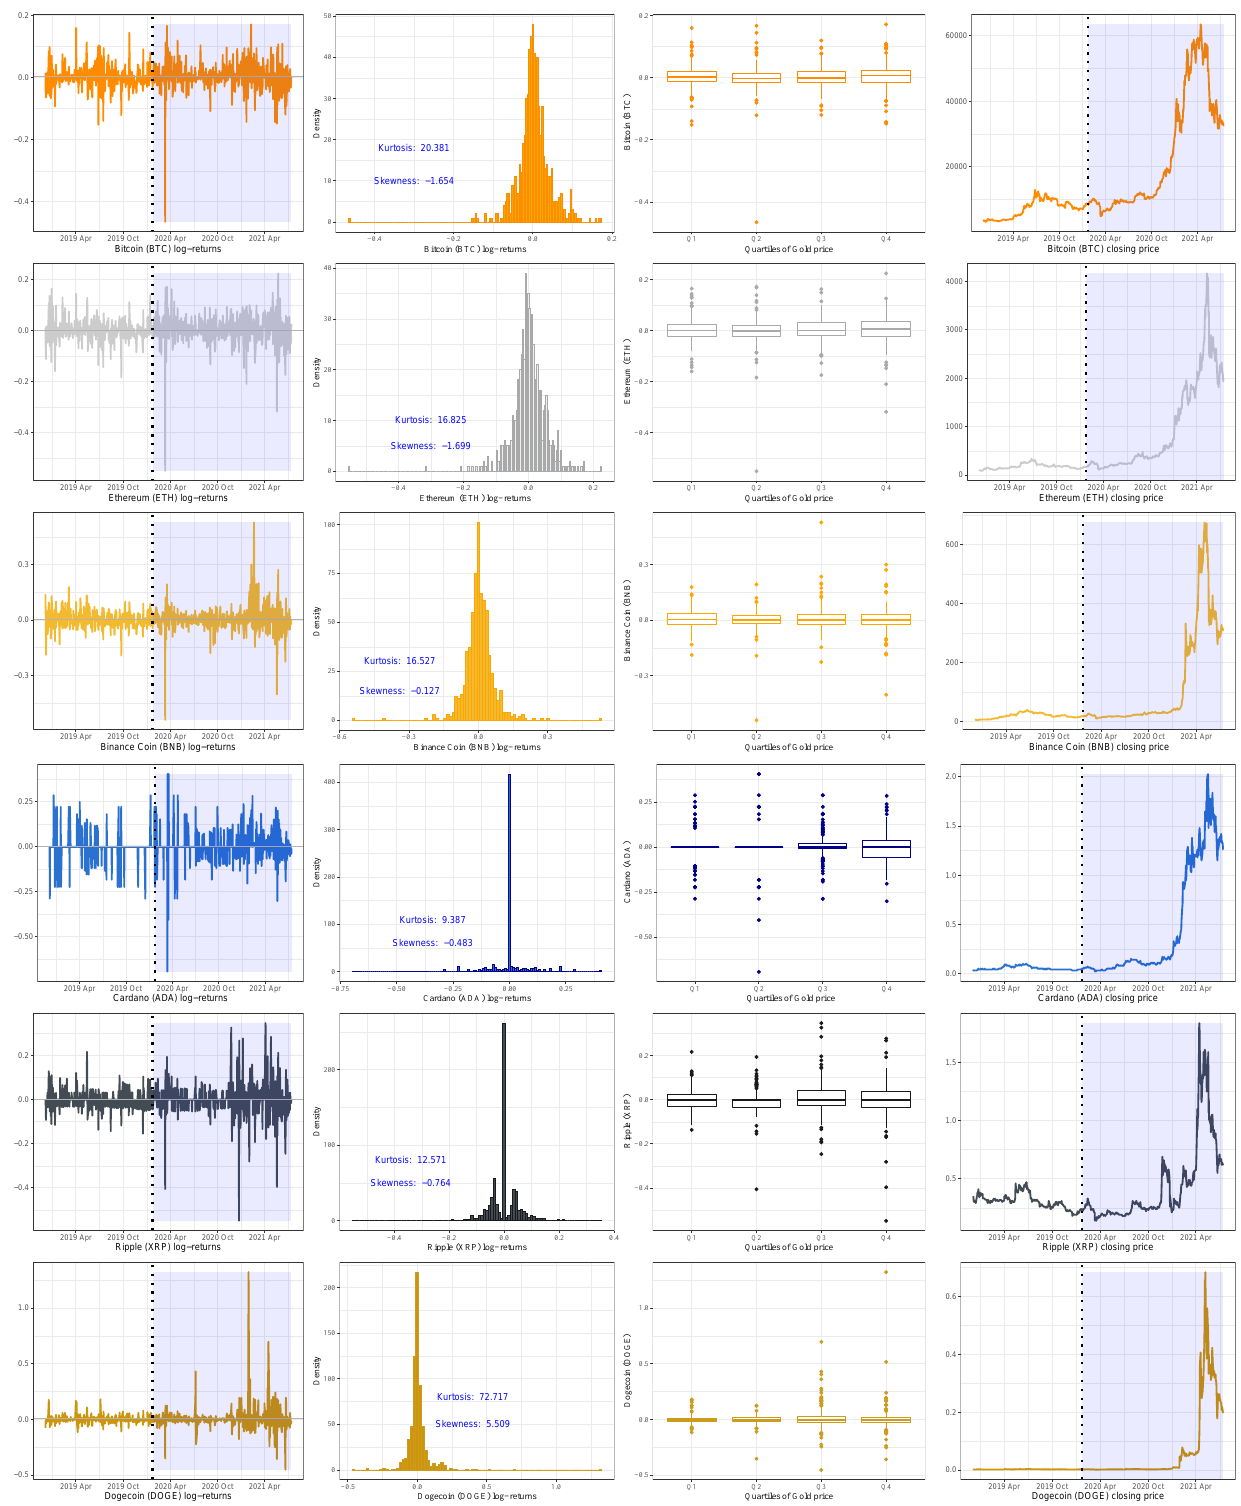
Figure 4. Cryptocurrency daily returns and box-plots of these returns based on the quartiles of the gold prices. The vertical dotted line represents the threshold between the pre-COVID-19 period ( left ) and during the COVID-19 period ( right ) so that the shaded zone represents the period after the pandemic’s beginning to visualize its impact on the cryptocurrency